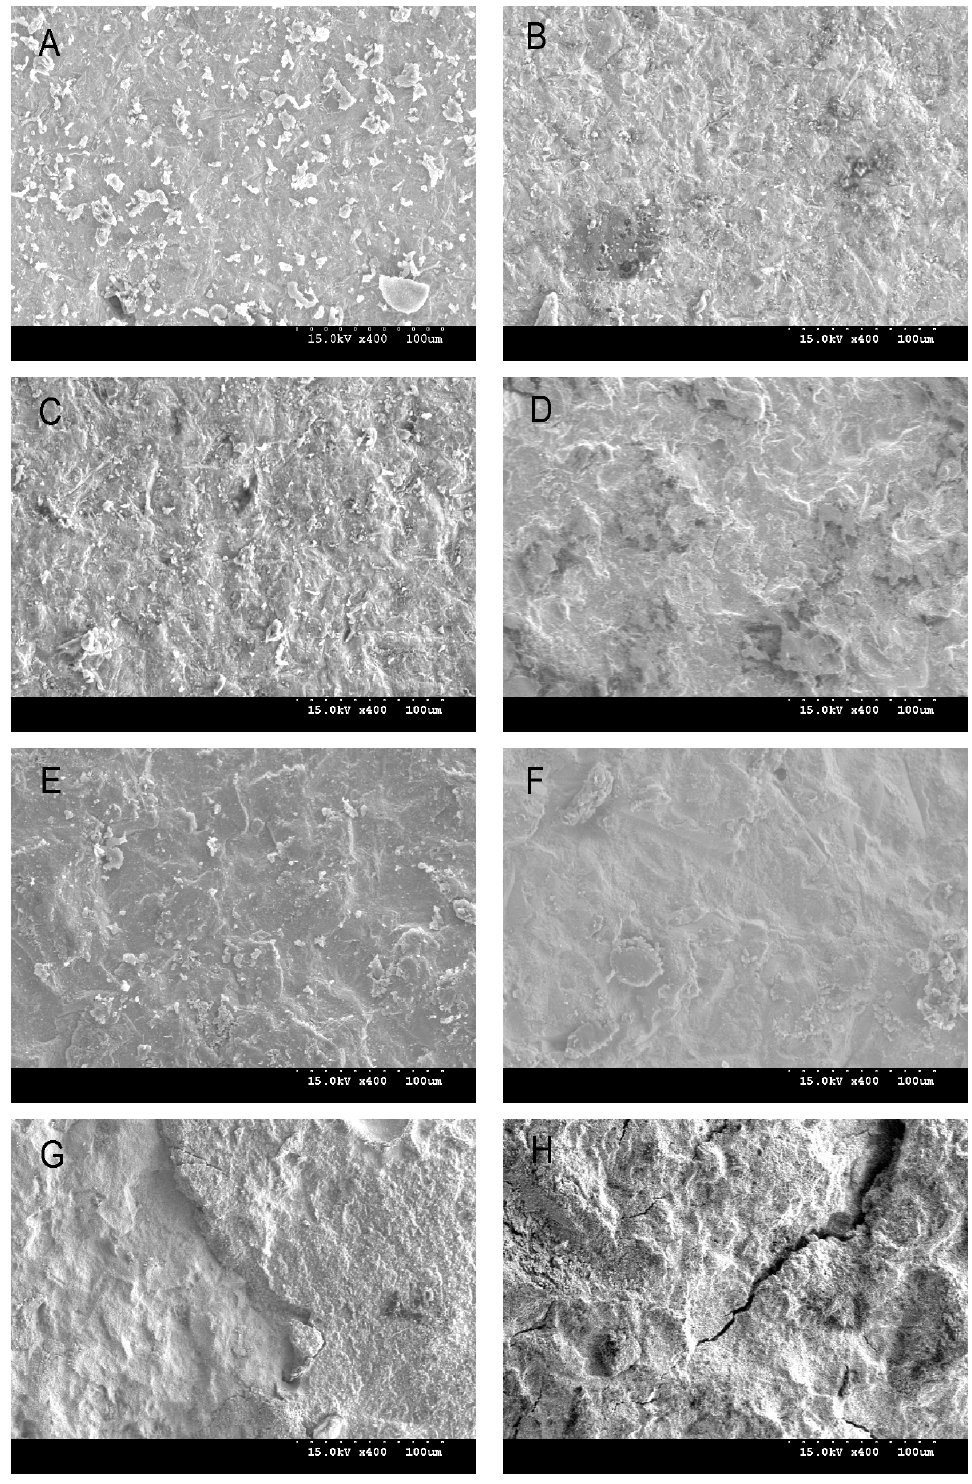
Figure 4. FE-SEM photograph (×400 magnification) of cement residues ( A ) Control bonded with Panavia F 2.0 without thermocycling; ( B ) Control bonded with Variolink N without thermocycling; ( C ) Control bonded with Panavia F 2.0 with thermocycling; ( D ) NoHF bonded with Variolink N without thermocycling; ( E ) 20HF1 bonded with Variolink N without thermocycling; ( F ) 20HF1 bonded with Variolink N with thermocycling; ( G ) 40HF2 bonded with Variolink N without thermocycling; ( H ) 40HF2 bonded with Panavia F 2.0 without thermocycling.